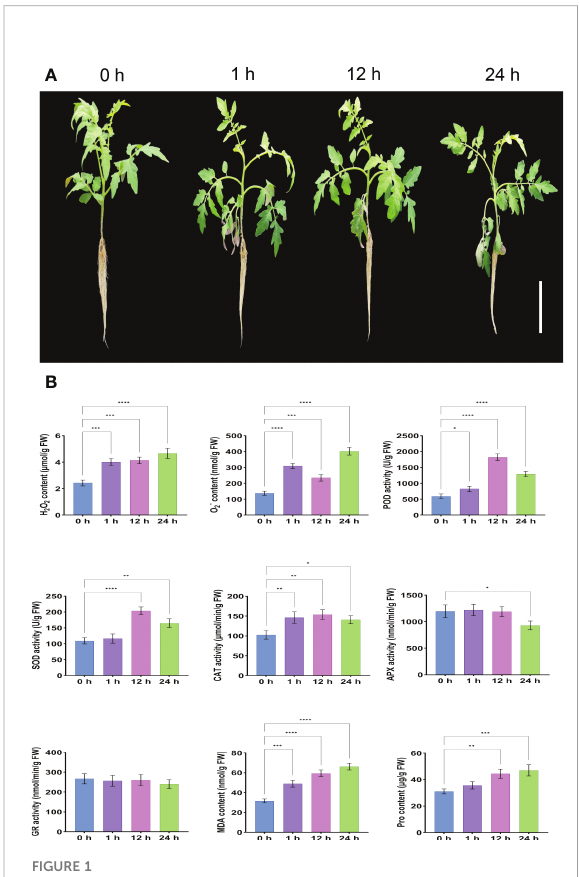
FIGURE 1 Determination of phenotypic changes and root physiological indices in S. lycopersicum after salt stress. (A) Phenotypic pictures of S. lycopersicum plants under different salt stress periods. (B) Measurement of physiological indices of S. lycopersicum roots during various salt stress periods. Three independent biological replicates were used to calculate the mean. Error bars indicate the standard deviation (SD) of the three biological replicates. Values indicate mean ± SD. Dunnett ’ s multiple comparison test was applied to verify the signi fi cance of differences (* P < 0.05, ** P < 0.01, *** P < 0.001, and **** P <